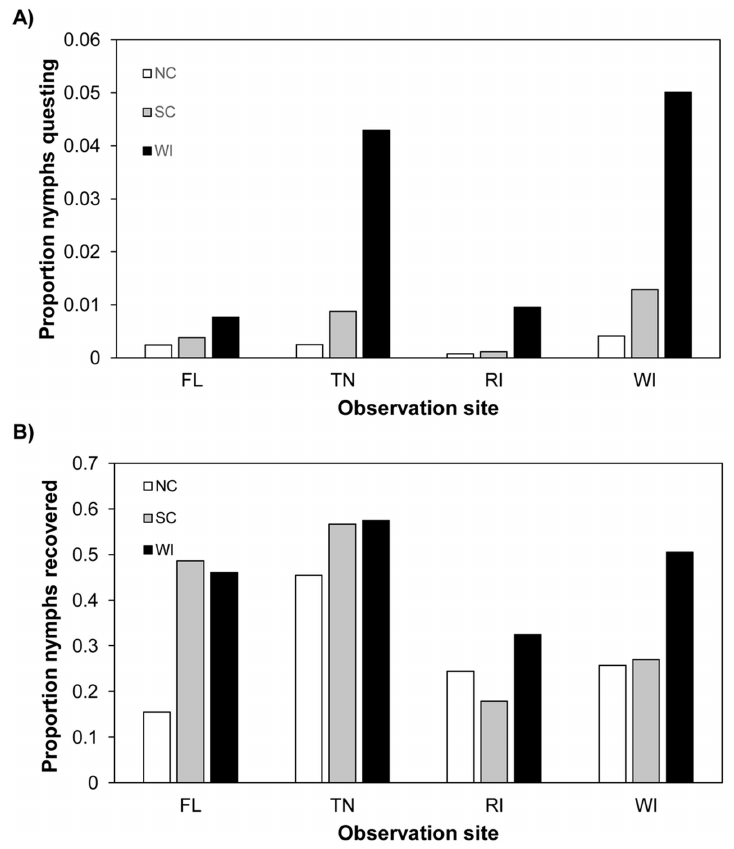
Fig 2. Questing behavior data from experimental arenas at northern and southern field sites; May- September, 2012. (A) Proportion of nymphs at each field site, from each origin, observed questing on stems, leaf litter, and arena walls. Wisconsin (WI) nymphs were observed in higher proportions compared to North Carolina (NC) or South Carolina (SC) nymphs at all four field sites. (B) Proportion of nymphs from each origin recovered at each field site when arenas were depopulated September 13 – 20, 2012. Recovery rates varied for each nymph origin at the four sites. The data used in this figure are given in (A) S3 Data and (B) S4 Data.